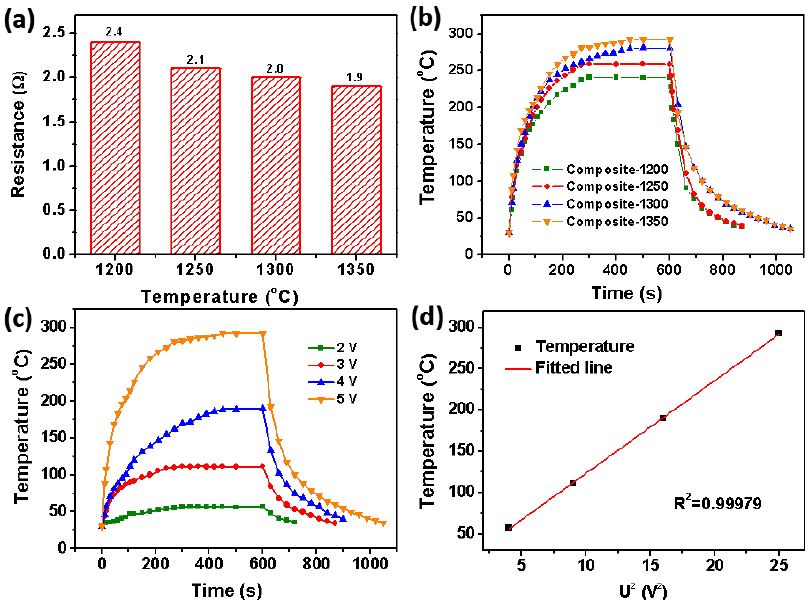
Figure 6. Electro-thermal performance of the composites. ( a ) Resistance of the specimens; ( b ) temperature changes of the specimens at 5 V; ( c ) temperature changes of Composite-1350 from 2 V to 5 V; ( d ) temperature-U 2 relationship for Composite-1350.